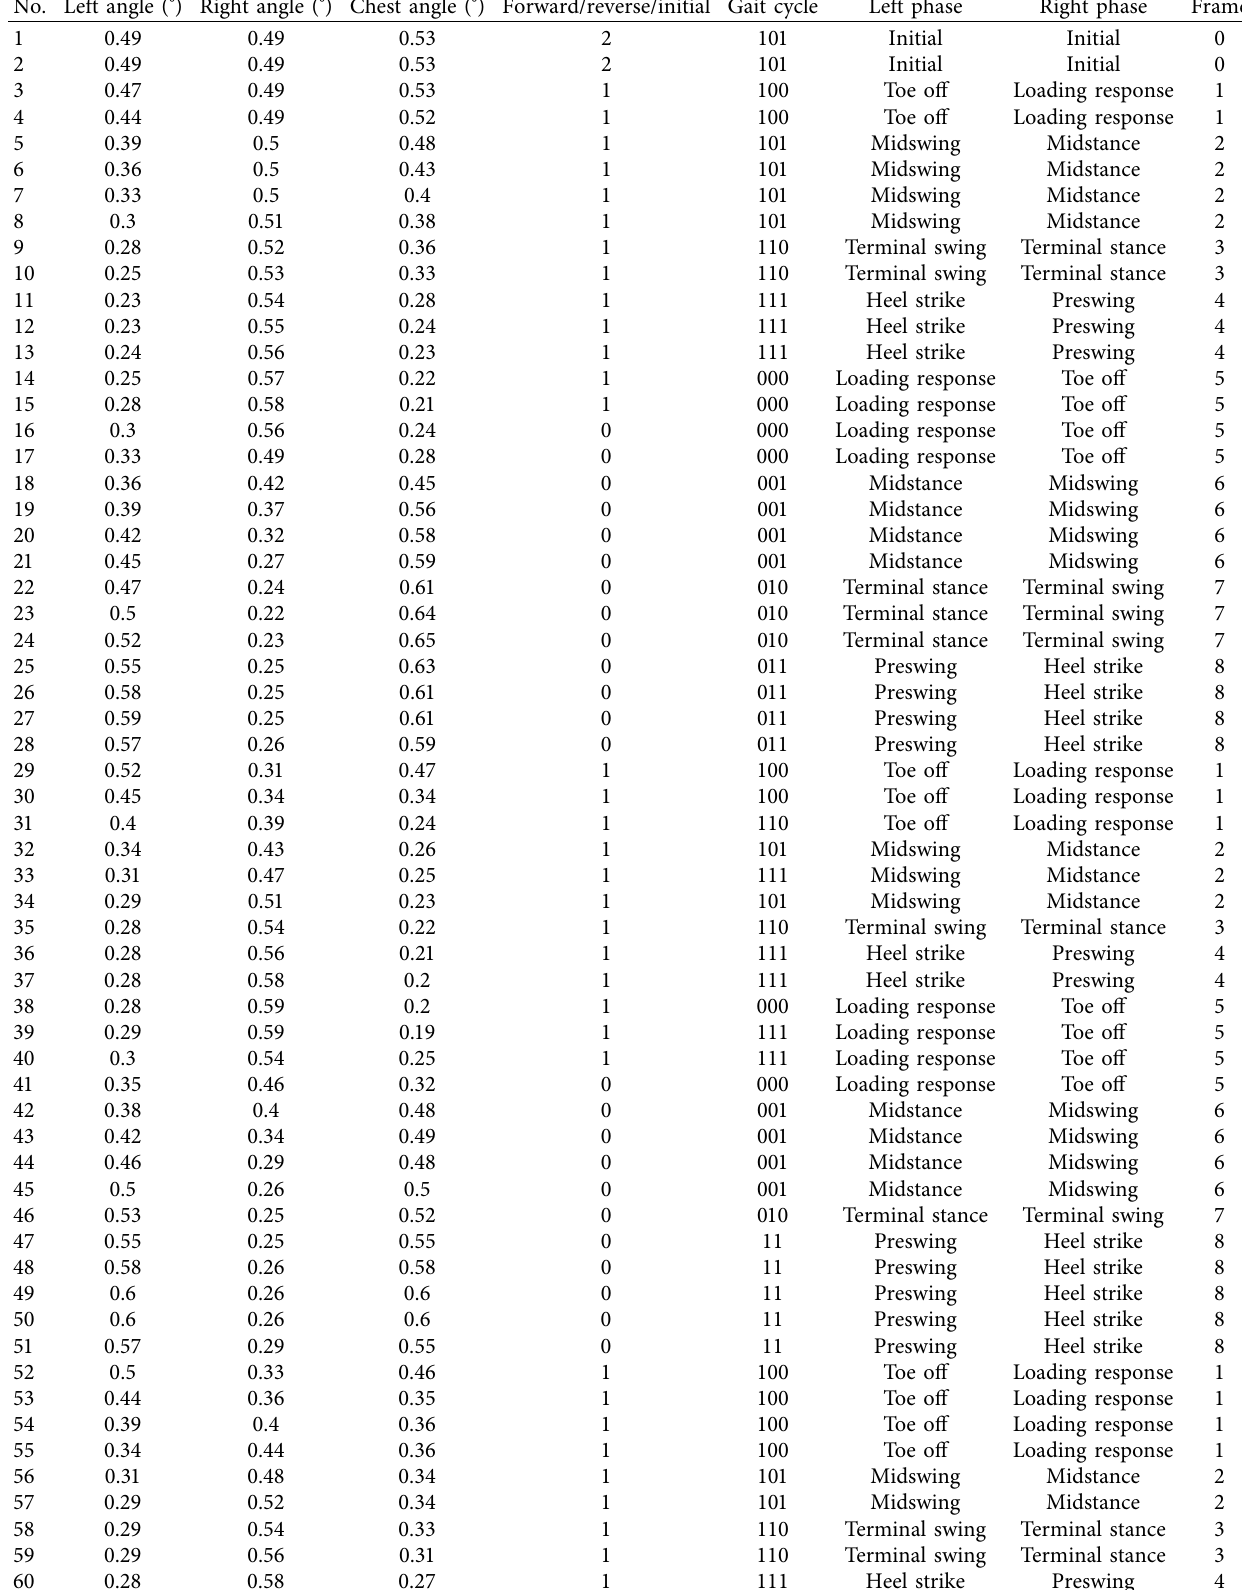
Table 3: Results from the proposed method of identifying walking